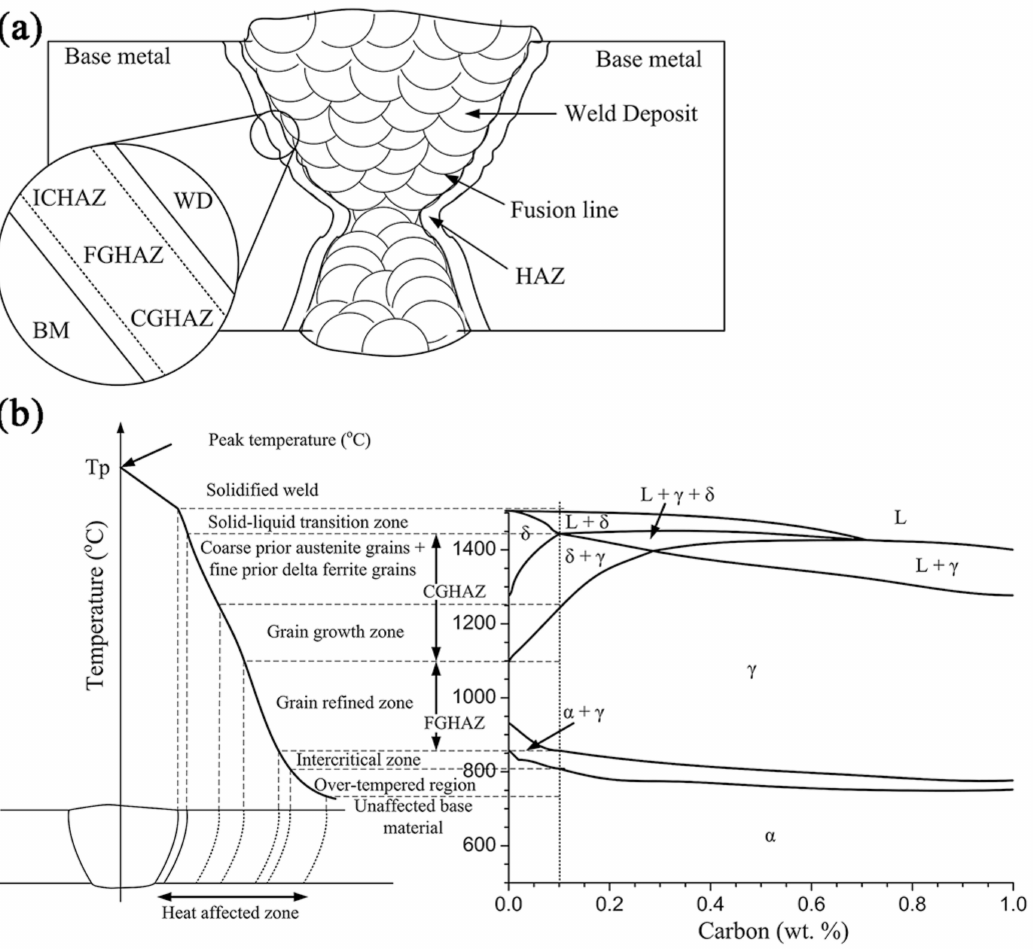
Figure 1. Schematic diagram of P91 heat a ff ected zone (HAZ) [23]: ( a ) The sub-zones and ( b ) the corresponding calculated equilibrium phase